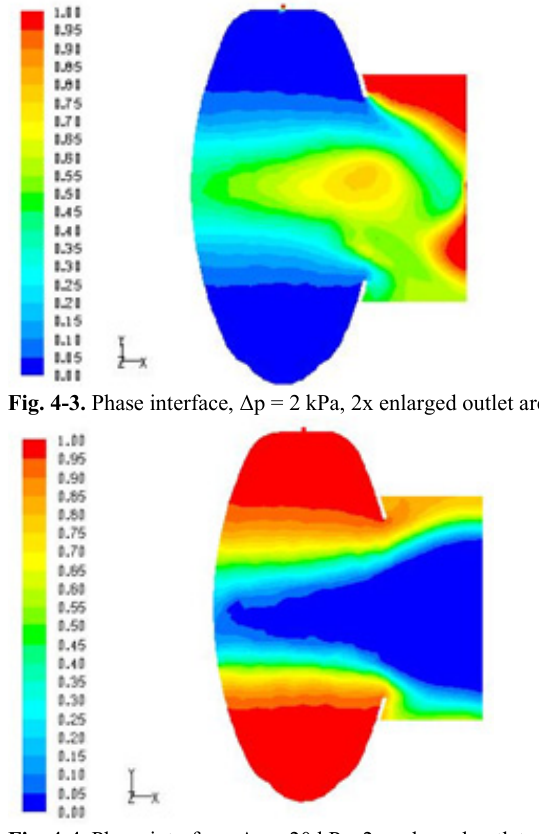
Fig. 4-4. Phase interface, Δ p = 20 kPa, 2x enlarged outlet area. (Attention, error: here, only, the water is red and the air is blue!)